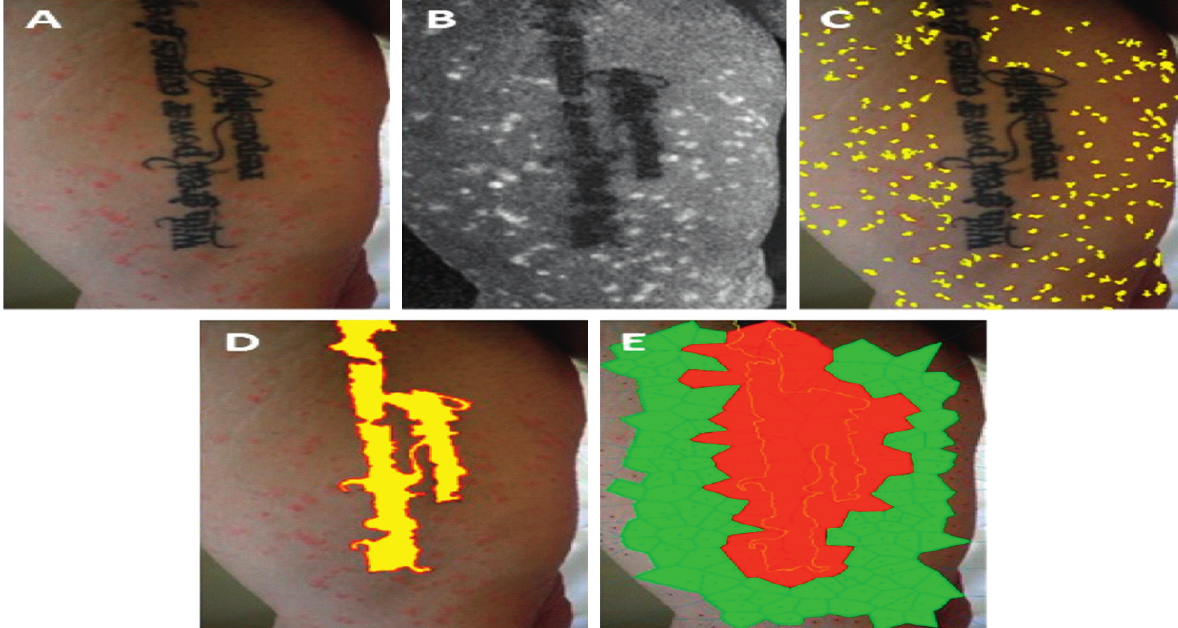
Figure 2: Psoriasis and tattoo #1. (a) Clinical picture. (b) Retained a ∗ color channel of L ∗ a ∗ b ∗ color space: high-peak intensity areas mark psoriasis lesions and low-level intensity areas correspond to tattooed skin segments. (c) Applying h-maxima transform followed by regional maxima, the lesional skin spots (patches) were extracted and are displayed in yellow pseudocolor. (d) Equivalently, the tattoo area was extracted by applying h-minima transform, followed by regional minima and is shown in yellow pseudocolor to enhance visualization. (e) The extracted psoriasis skin lesions’ centroids (panel (C) applied to generate Voronoi diagrams (tessellation) of the tattoo area. Voronoi polygons with and without overlapping with the tattoo area (yellow border) are displayed in red and green pseudocolors, respectively.